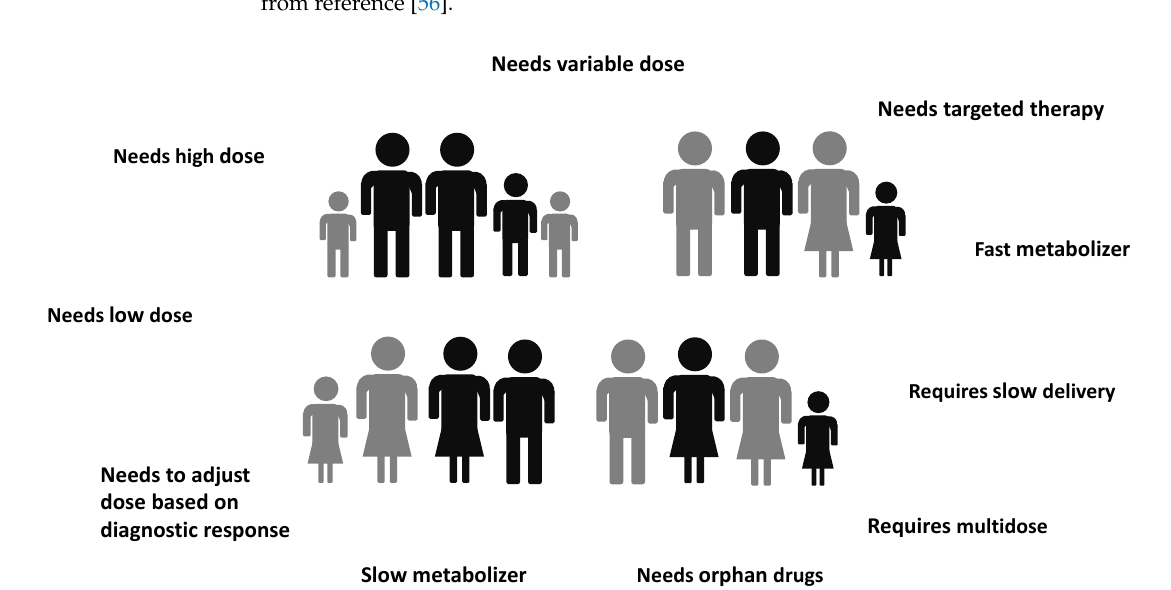
Figure 3. Personalized medical approach. * Images adapted from reference [55]. ** Images adapted from reference [56].